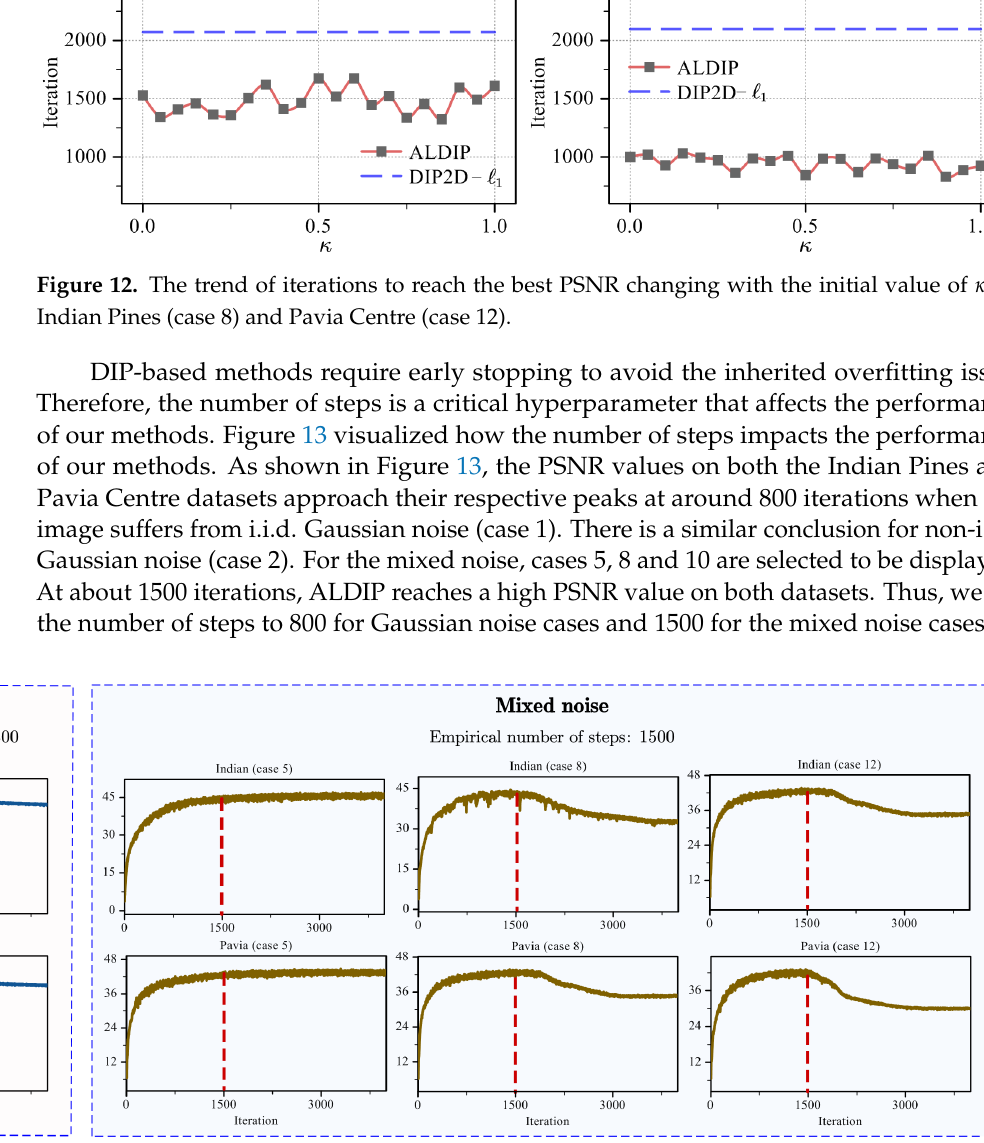
Figure 13. The empirical number of steps for experiments and how different numbers of steps impact the noise removal